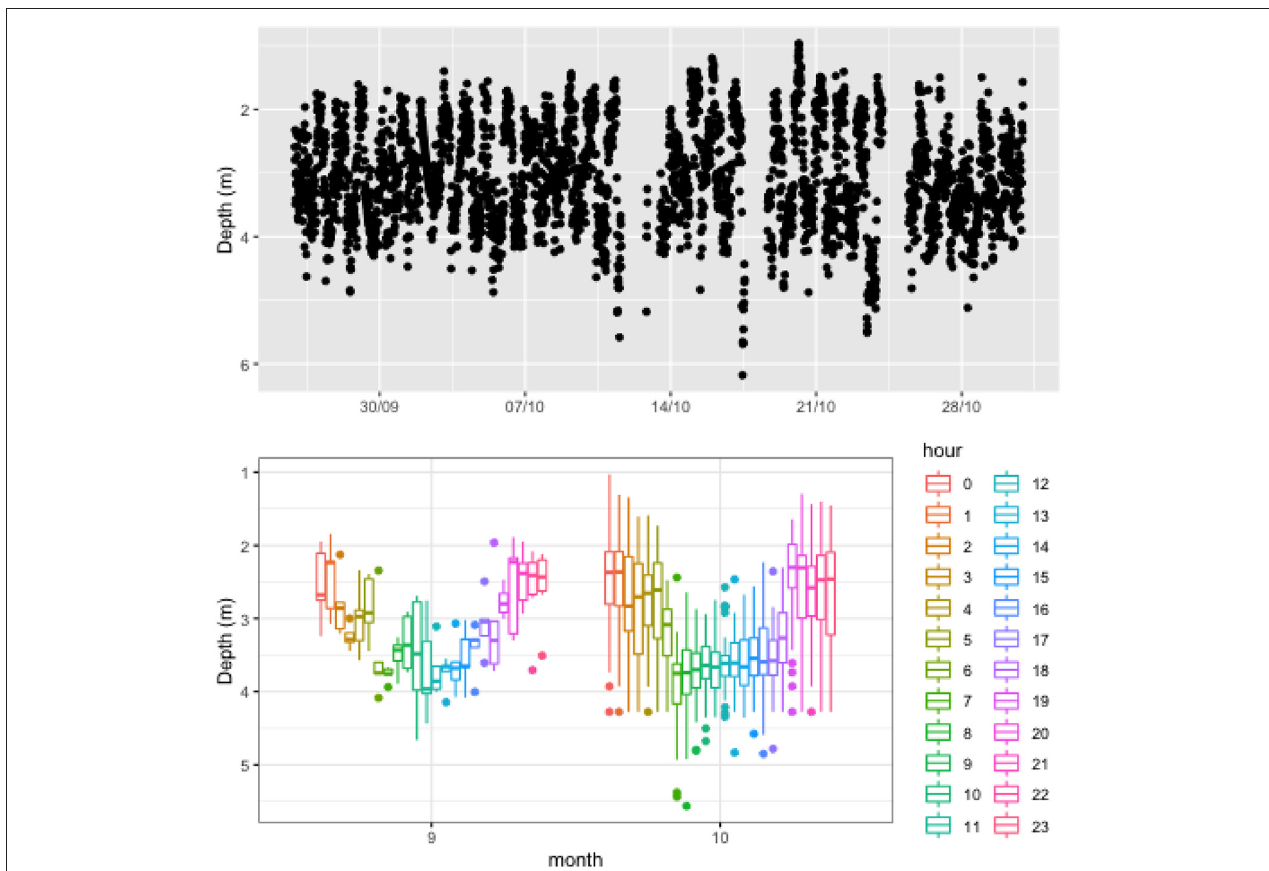
FIGURE 6 | Vertical distribution of fish in a cage at CAN farm illustrating the evolution of the centrepoint of fish biomass over the duration of study period (top) and boxplot of the data grouped into hourly intervals for each month (bottom) . The box plot provides insight into distinct patterns developing in the data at different times with the colour legend representing hour of day. Lines extending from the boxplot represent the range of data (i.e., minimum and maximum values), while the box section reports 25th percentile, median, and 75th percentile values. Filled circles represent outliers for the